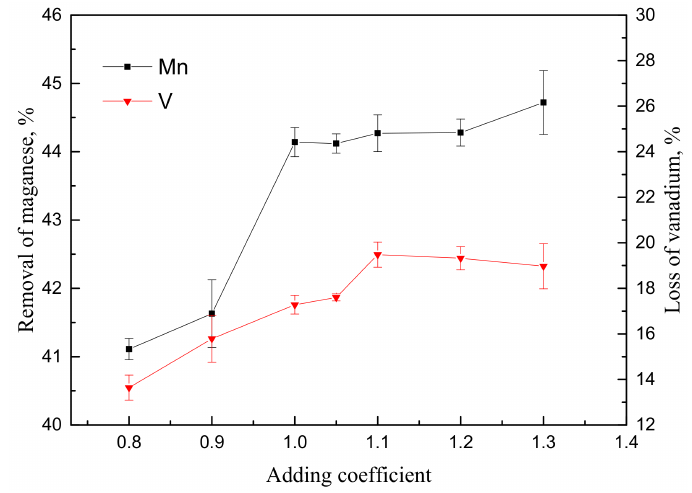
Figure 13. Effect of the adding coefficient of (NH 4 ) 2 S 2 O 8 on the removal of manganese and the loss of vanadium.